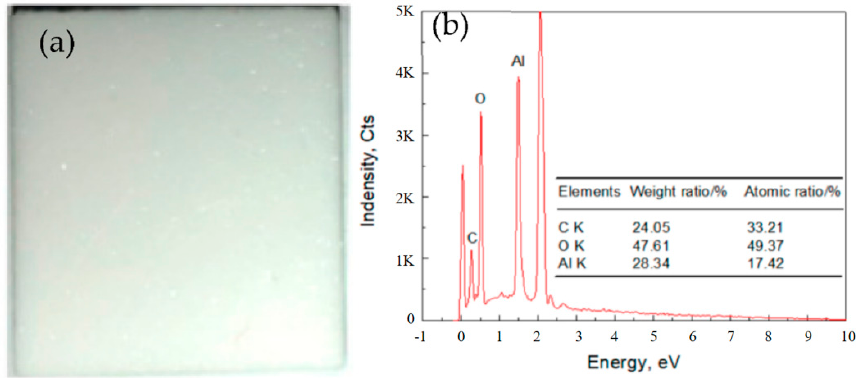
Figure 1. ( a ) Al 2 O 3 ceramic and ( b ) its chemical composition.